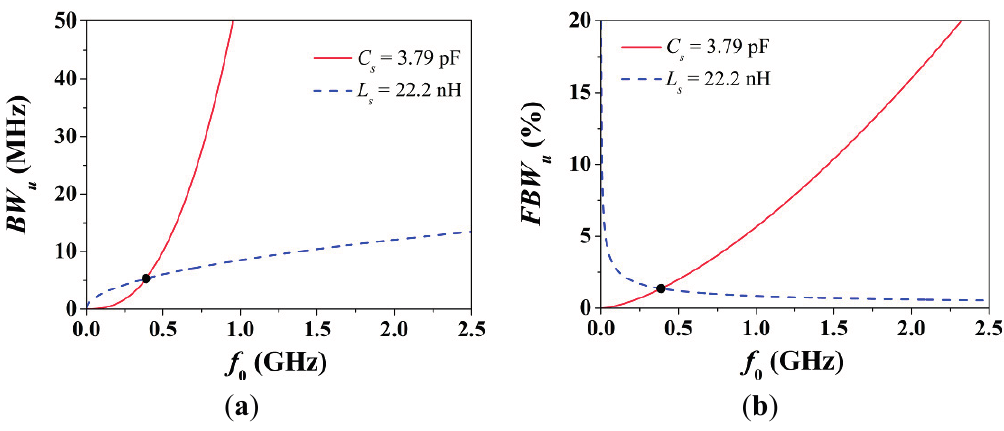
Figure 9. ( a ) Absolute fractional bandwidth at +3 dB of an unloaded resonator given by Equation (10) versus the resonance frequency; and ( b ) its fractional bandwidth. The circuit parameters are those of the S-SRR-based structure in Table 1. In order to sweep the resonance frequency, either the capacitance or the inductance is considered to be constant. The specific operating point in Table 1 is also mapped.